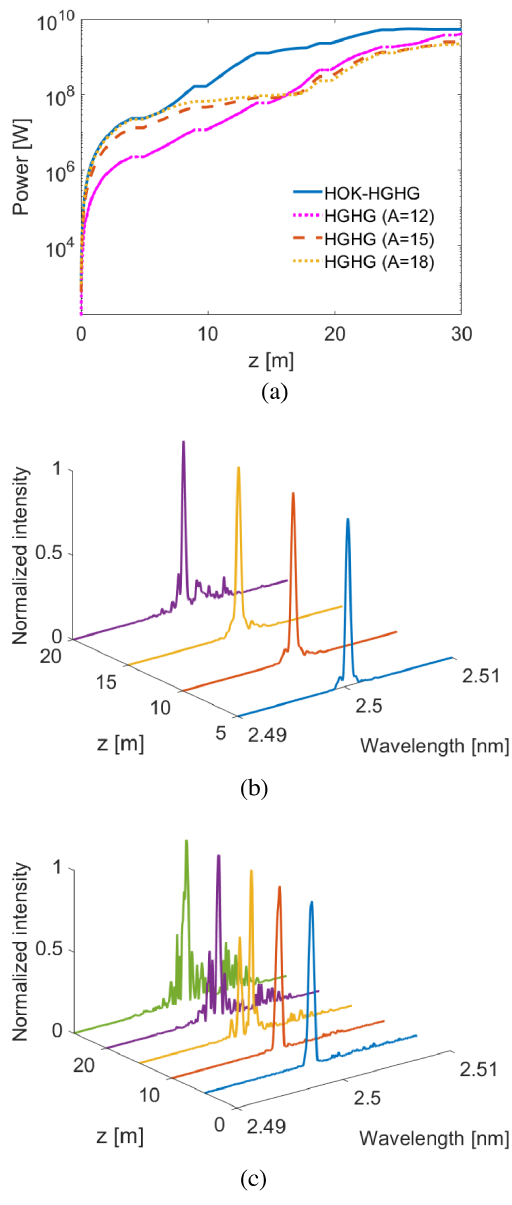
4. (a) The gain curves for an FEL output wavelength of 2.5 nm along the radiator for the four cases [HOK HGHG and the standard single-stage HGHG ( A ¼ 12 , 15, 18)]. The output spectrum profiles at different locations along the radiator for (b) the HOK HGHG scheme and (c) the standard single-stage HGHG ( A ¼ 15